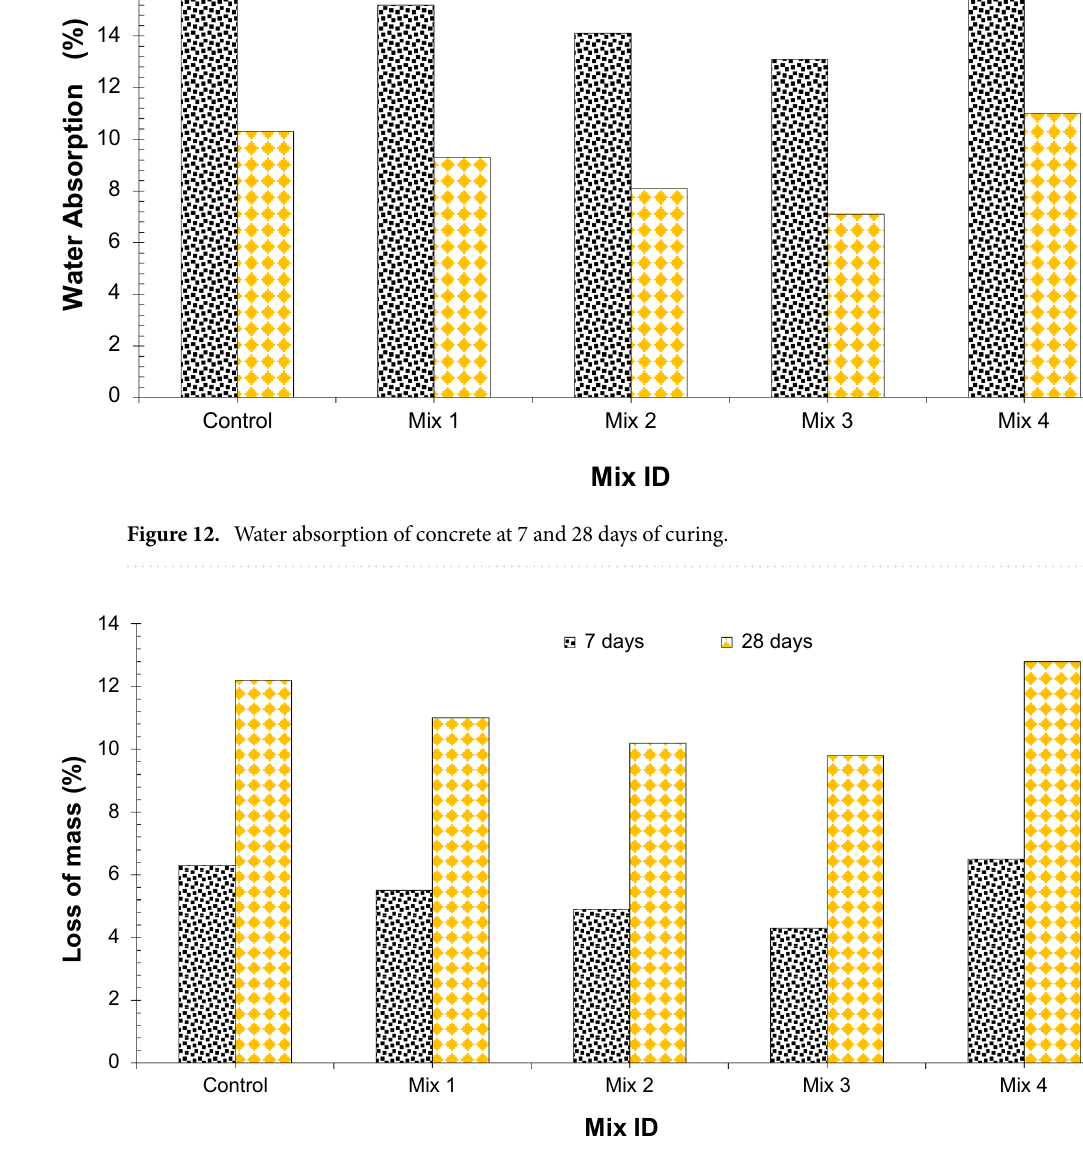
Figure 13. Acid resistance of concrete at 7 and 28 days in